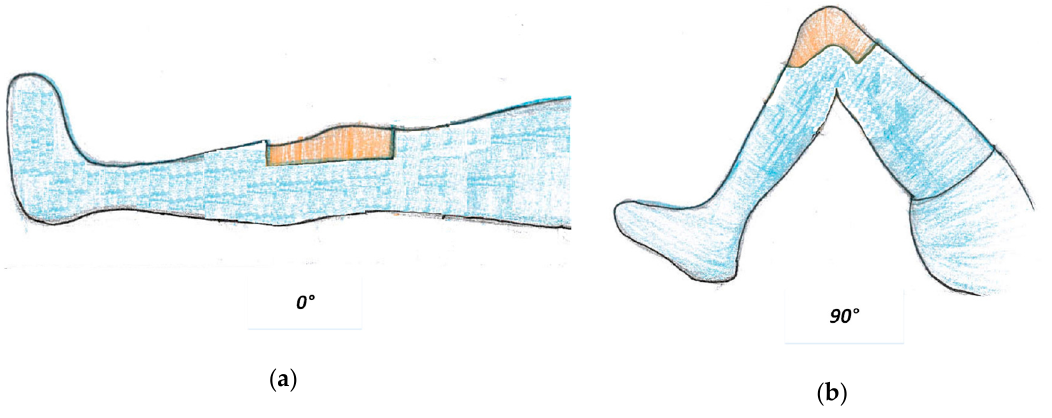
Figure 12. Typical angles for instant prosthesis pose check: ( a ) 0°, ( b ) 90°.